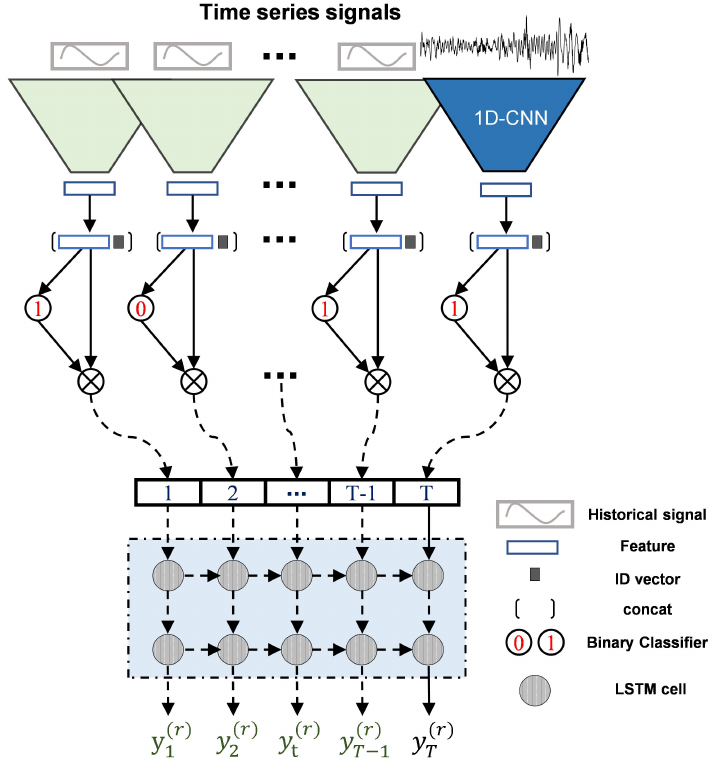
Figure 4. The proposed encoder–decoder architecture unrolled in time. LSTM: long short-term memory; 1D-CNN: one-dimensional convolutional neural